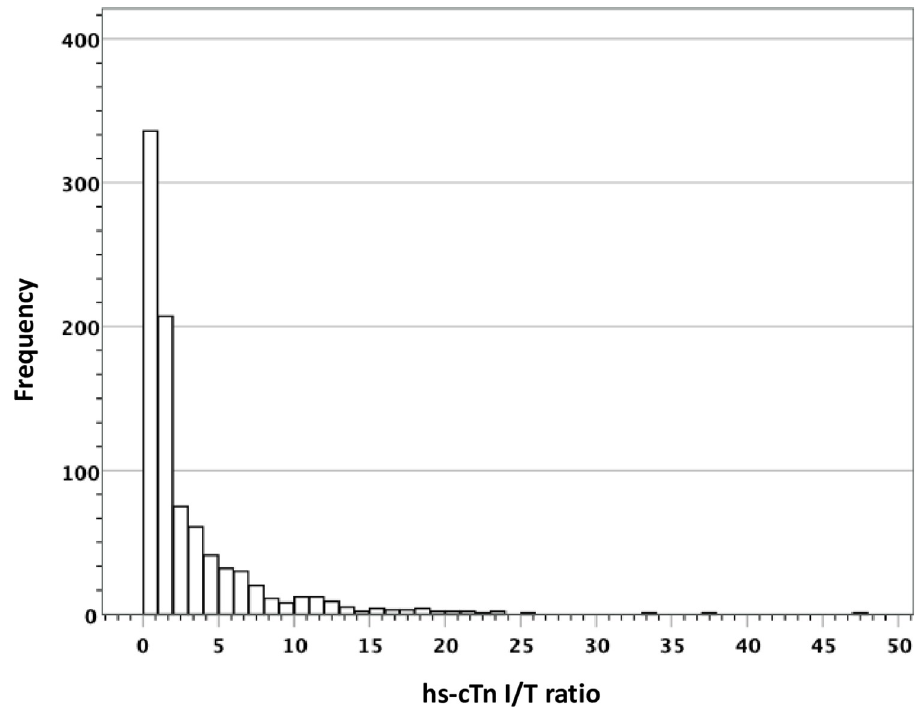
Fig 2. Distribution of hs-cTn I/T ratio values.